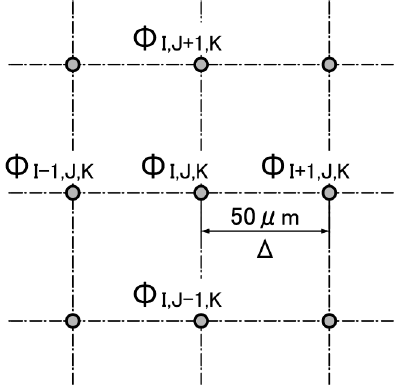
FIG. 7. Nodes for numerical calculation. The mesh was